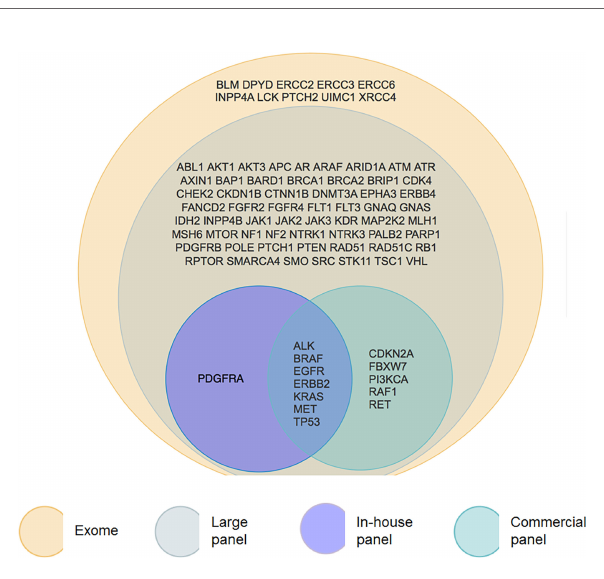
FIGURE 2 | Venn diagram of presenting genes with a mutation found by each panel. We can observe that exome (yellow) contains large panel (grey) that contains itself smaller panels. In-house panel (purple) and commercial (green) panel have some common genes but have also some differences in gene content.